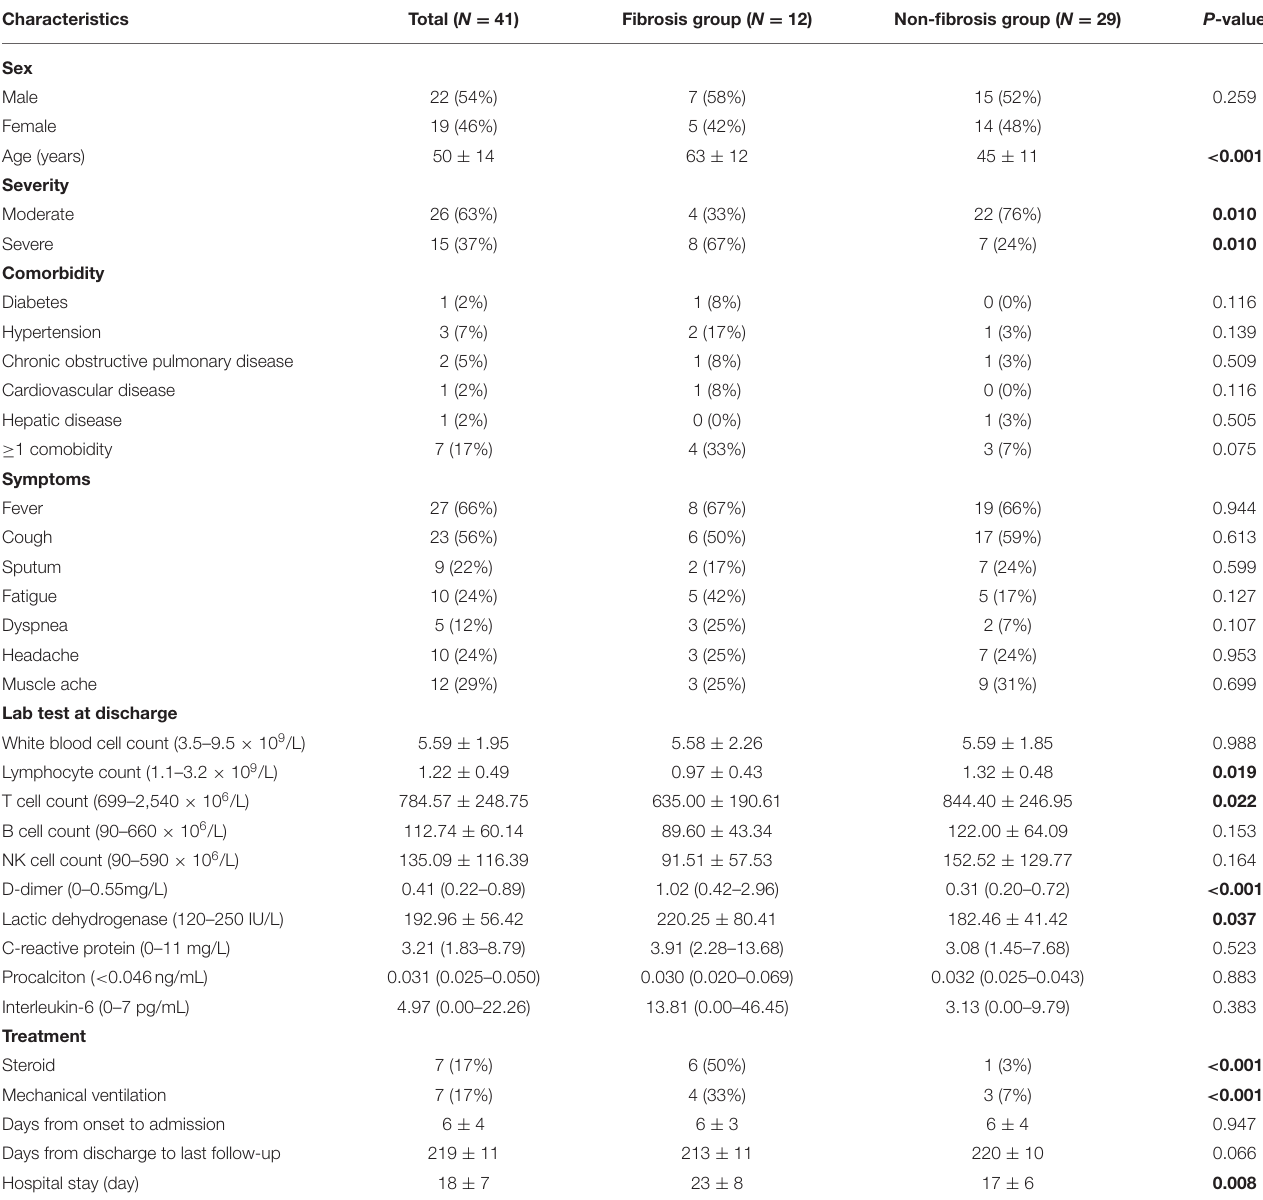
TABLE 1 | Clinical and laboratory characteristics of the patients included in the present study.